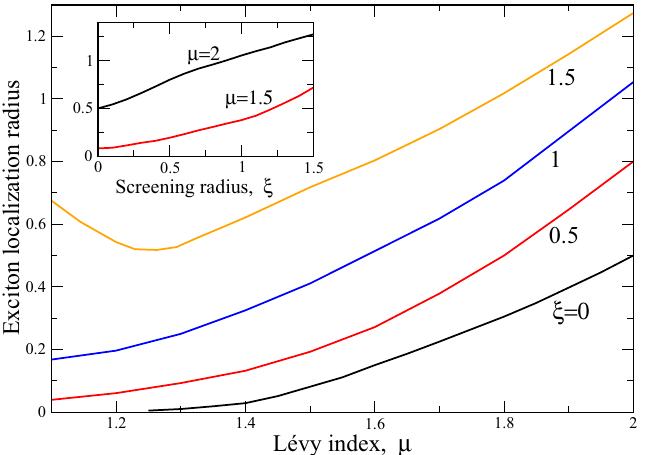
Figure 5. Exciton localization radius ¯ r (in the units r 0 µ (12)) versus Lévy index µ at several values of screening radius ξ , shown as the figures near curves. Inset reports the dependence ¯ r (ξ) at two representative values of µ , shown near